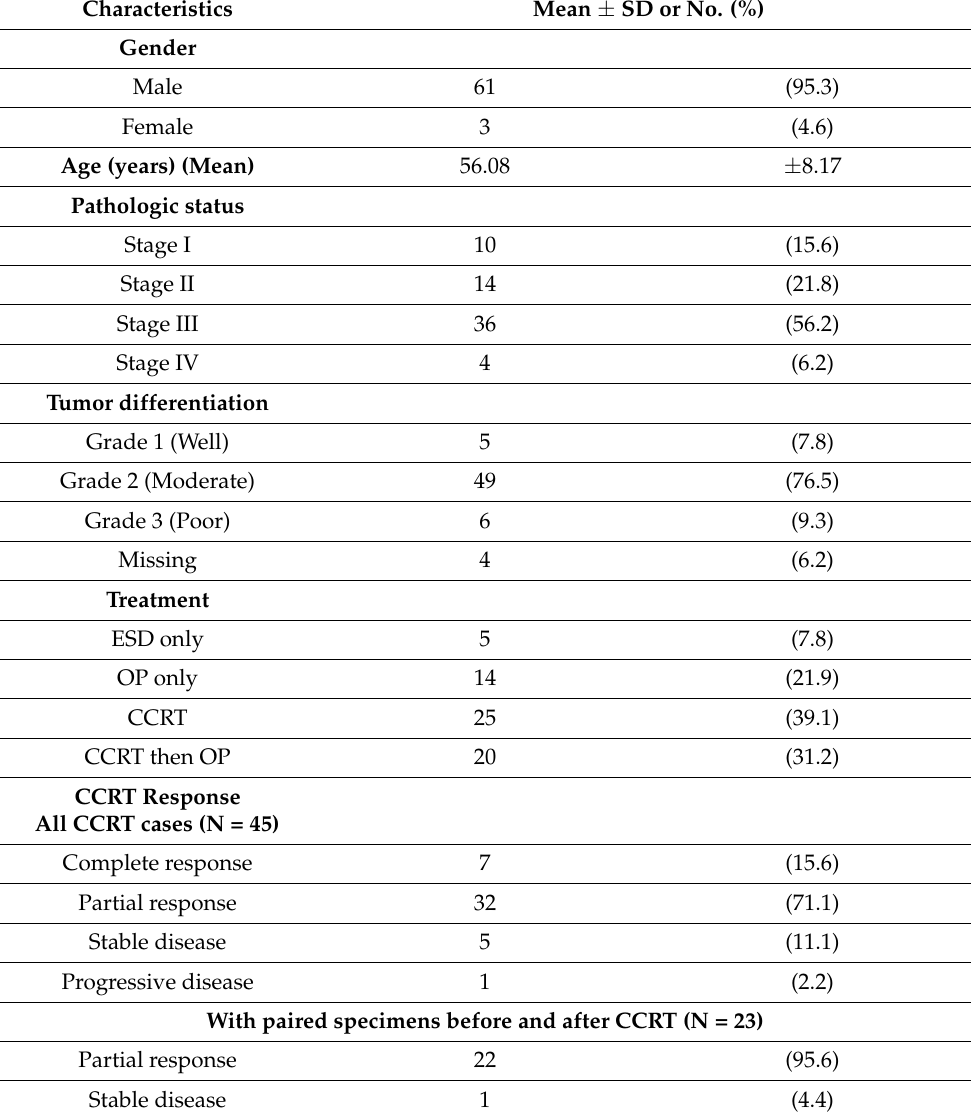
Table 1. Clinicopathological characteristics of the 64 ESCC